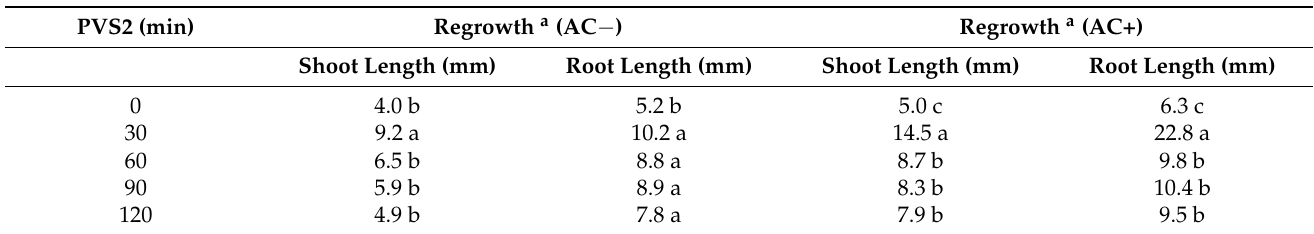
Table 1. Effect of activated charcoal (AC) on the plantlet regrowth of encapsulated Castanea sativa EAs subjected to various dehydration times with PVS2 following immersion in LN evaluated 5 weeks after cryostorage, rewarming and plating.